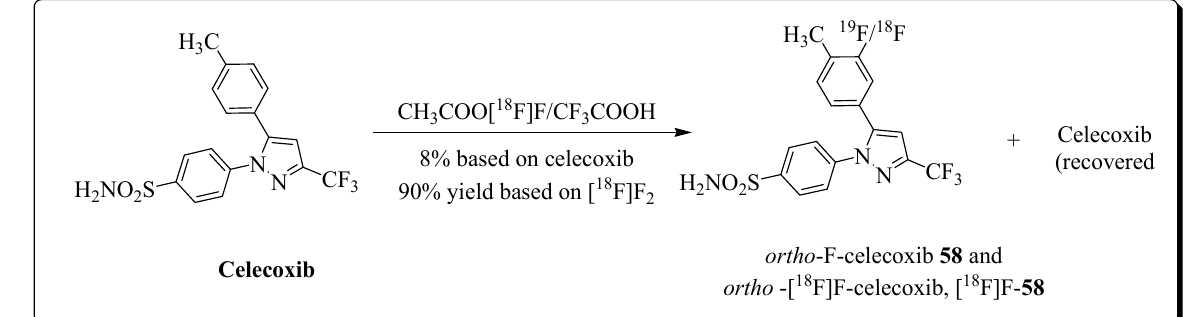
Figure 17. Preparation of ortho -[ 18 F]F- 58 .